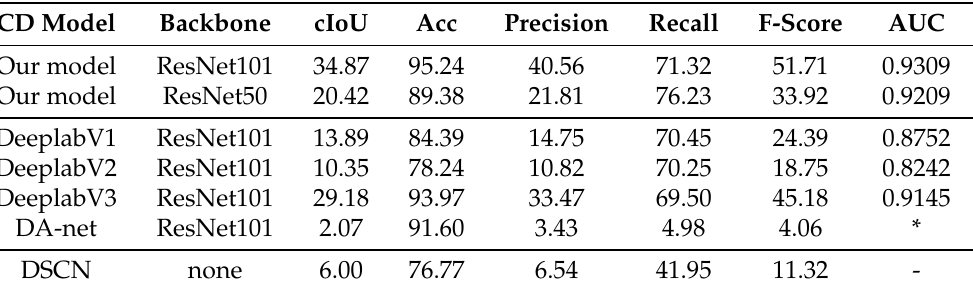
Table 2. Change detection performance. *: Since the DA-net does not perform well on our change detection task, we do not provide the ROC and AUC of DA-net. -: Since DSCN does not generate the results through a softmax layer, we can not compare the